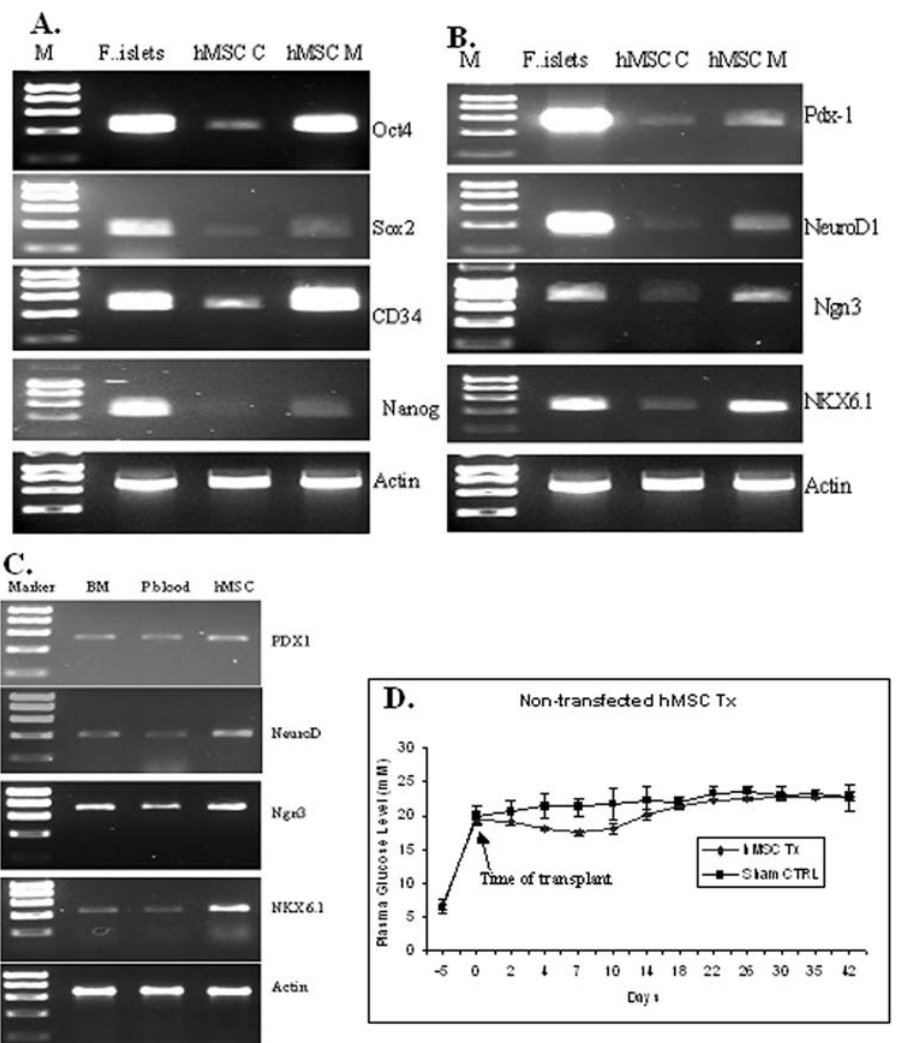
Figure 1. Characteristics of human marrow stromal cells (hMSCs). Panel 1a and 1b show the typical gel analyses of hMSCs (220R and 240L) in term of expression of makers for stem cells (1a) and pancreatic endocrine cells (1b); Lane M is the molecular weight, lane F, freshly isolated human islets, lane hMSC C is the hMSC in cluster culture and lane hMSC M is the hMSC in monolayer culture. Panel 1c shows the similarity in the expression of pancreatic endocrine cell marks among local generated primary human stromal cells and the 2 hMSCs lines: 220R and 240L. Lane BM is the primary stromal cells derived from bone marrow and Lane p blood is the primary stromal cells derived from peripheral blood. Panel 1d shows the potential of hMSCs to improve hyperglycaemia in the diabetic SCID mice. All experiments were repeated at least 3